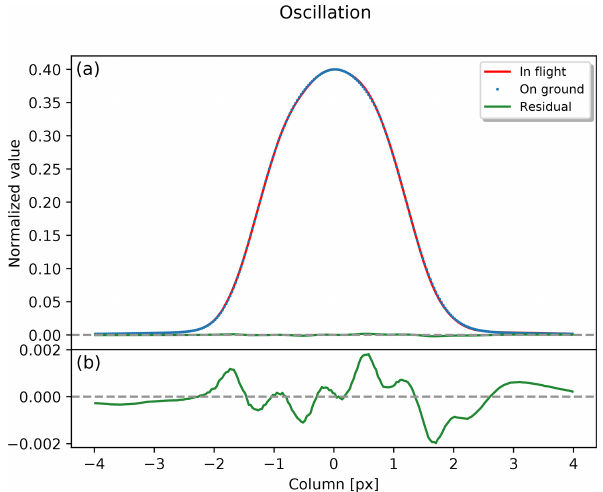
Figure 16. Comparison between the ISRF measurements taken during the ground-based calibration campaign and the E1 phase. Panel (a) shows the normalized pixel response in-flight (red) and on the ground (blue). The residuals are plotted in green. Panel (b) shows a zoomed in section of the